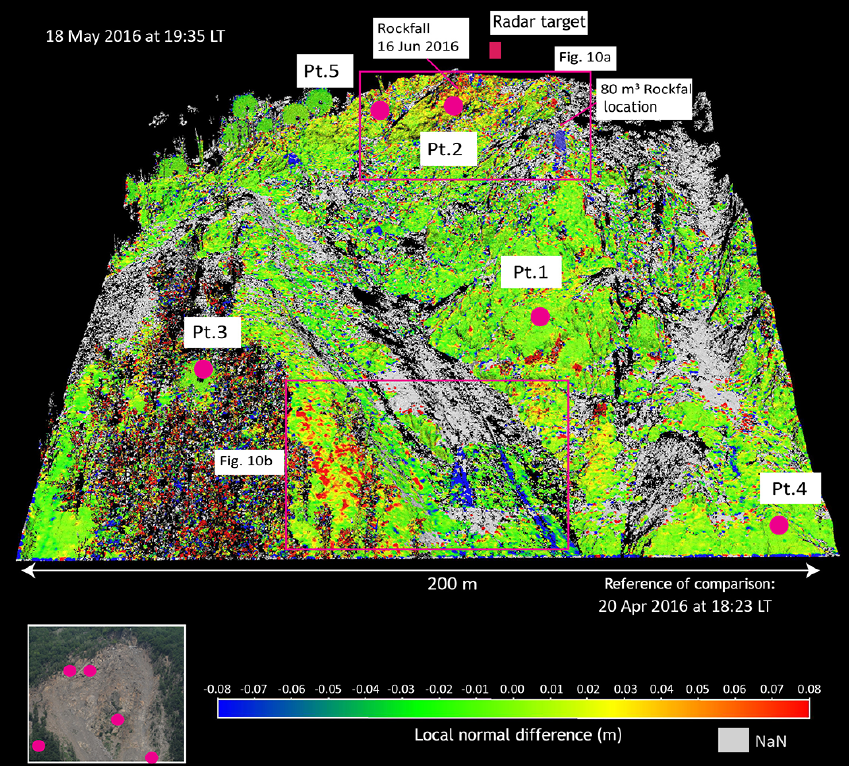
Figure 9. Change detection results for 18 May 2016 at 22:35LT relative to a reference scan from 20 April 2016 at 18:23LT. Five points of interest are marked and used to extract distance time series data and the location of two significant rockfall events are marked. Point 1 represents stable rock surface, Point 2 is located on the rock surface at the location of the rockfall on 16 Jun 2016, Point 3 is located on a stable reflective target, Point 4 is located on debris slope and Point 5 is located on the frontal zone of the